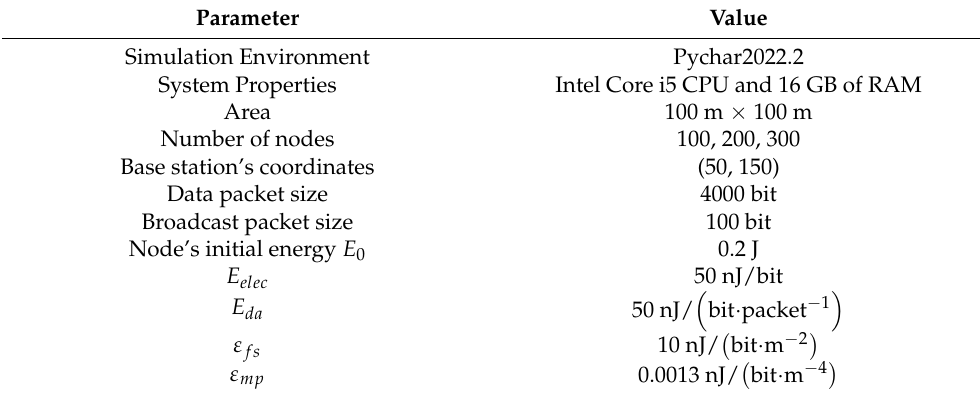
Table 2. Experimental setting.